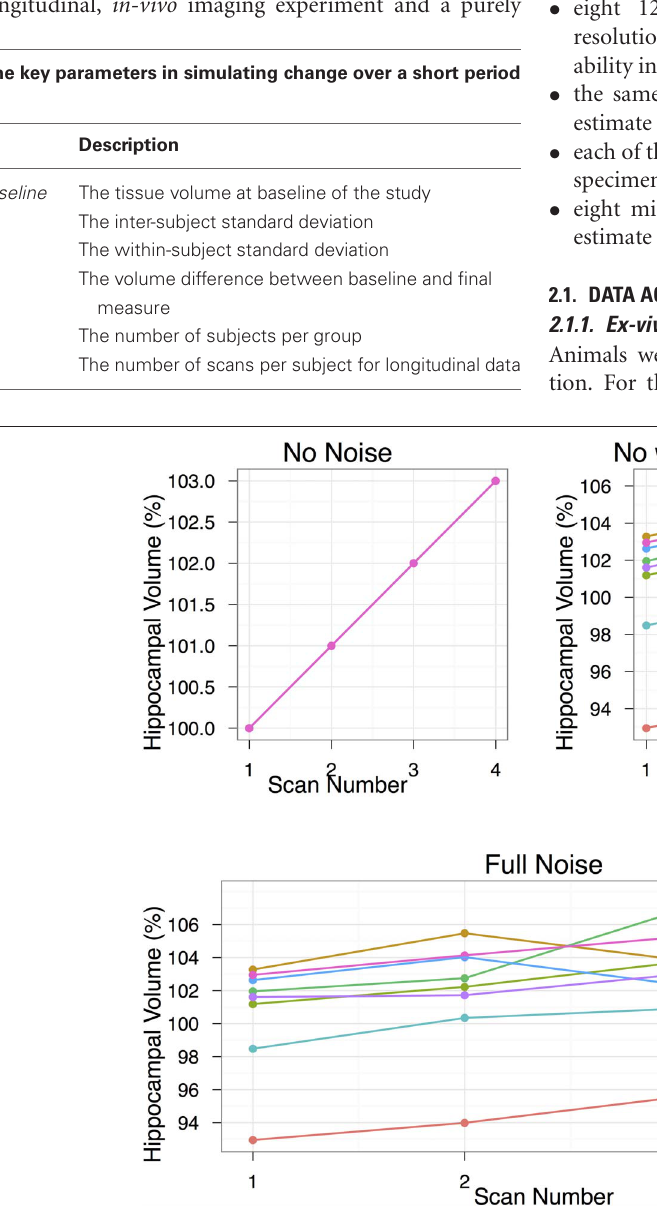
repeated scans. In all cases we start with hippocampal volume at 100%, and by the end of the study that volume is to increase by 3%. The second group, not shown, is a control group with no hippocampal volume changes. The simulation shown in this figure includes eight subjects per group and four scans per